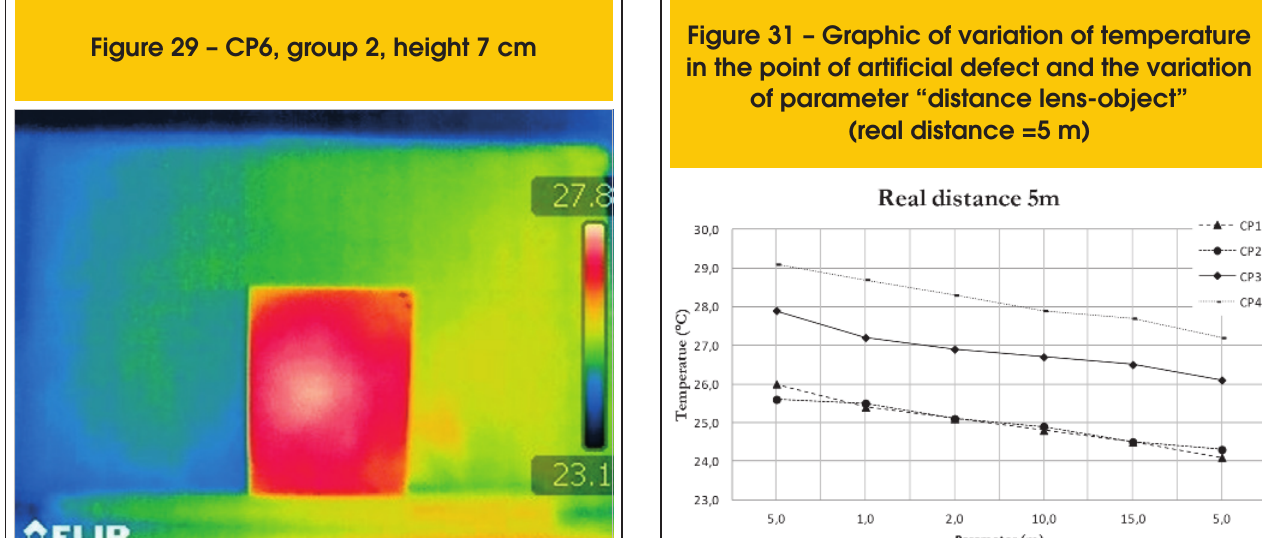
Figure 31 – Graphic of variation of temperature in the point of artificial defect and the variation of parameter “distance lens-object” (real distance =5